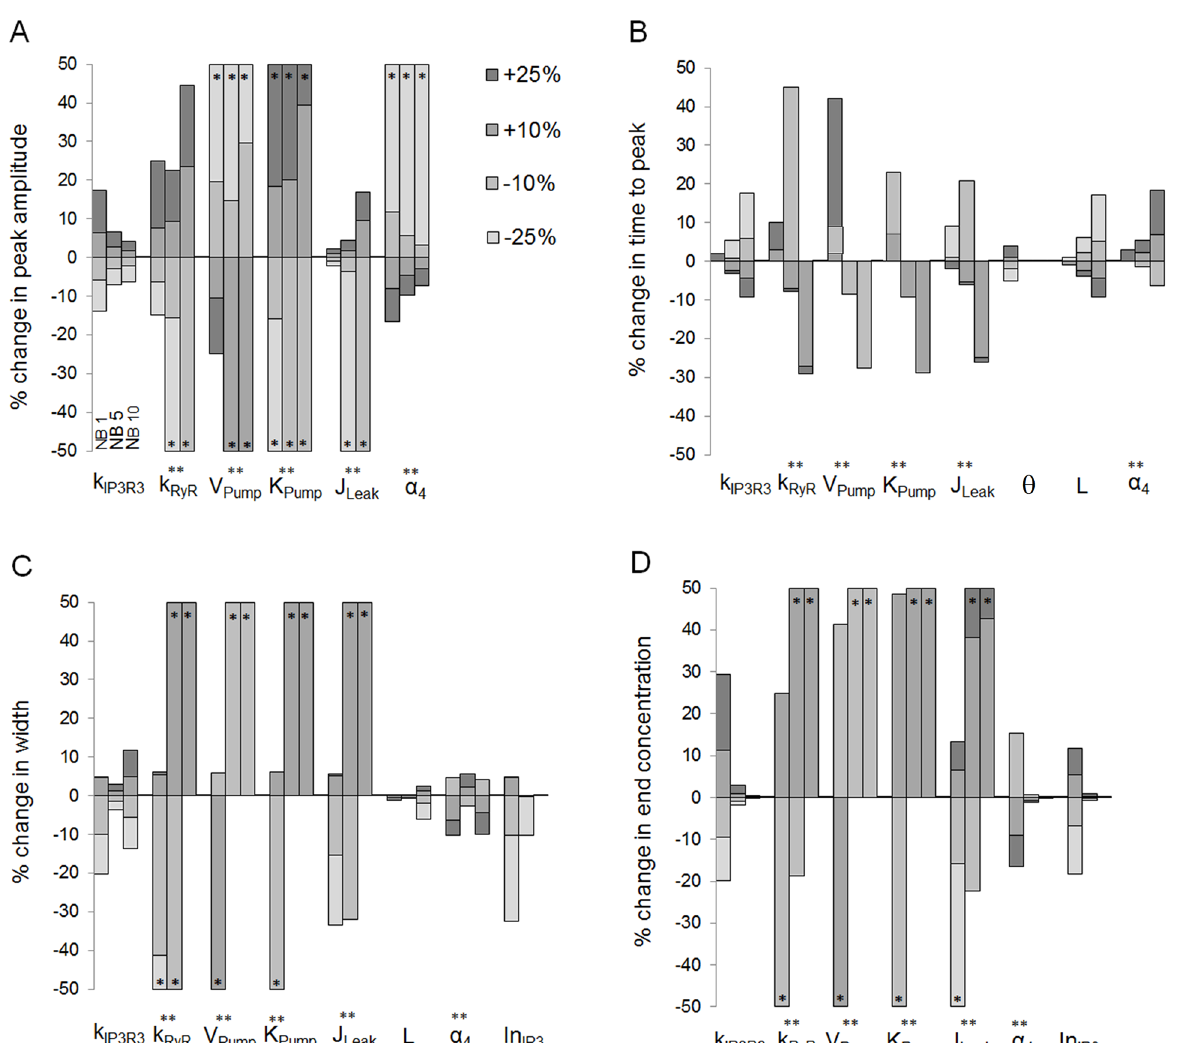
Fig 6. Sensitivity analysis of the model parameters. Percentage changes in Ca 2+ wave (A) peak amplitude, (B) time to peak, (C) Ca 2+ wave width at half maximum, and (D) end Ca 2+ concentration at 90 seconds ’ time point due to changes in model parameters k IP D D In Ca 2 þ , IP 3 , and Ca 2 þ as marked in the x-axis. The analysis was carried out in NB layers NB1, NB5 and NB10 as denoted in (A) for parameter amount of modification (-25%, -10%, +10% or +25%) is shown in the grayscale of the histogram. The histogram bar is marked with asterisk ( * ) if the change was greater than 50%, and with double asterisk ( ** ) if parameter modification did not result typical Ca 2+ waveform. Regarding each Ca 2+ wave feature, the parameter is illustrated only if the change was more than